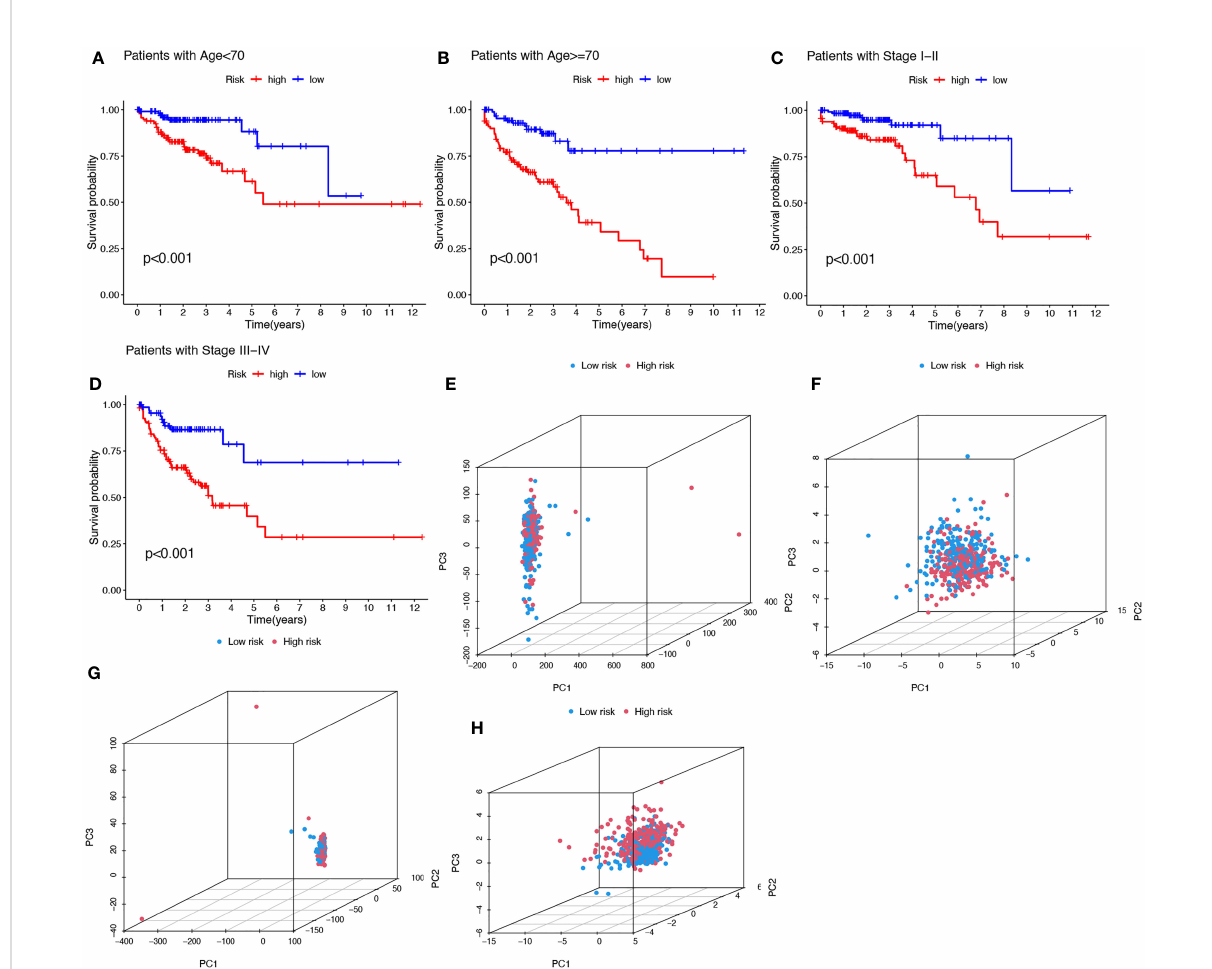
FIGURE 5 Kaplan-Meier plots depicting subgroup survival analysis strati fi ed by age (A, B) and stage (C, D) . PCA plots depicted the distribution of samples based on the expression of all genes (E) , cuproptosis-related genes (F) , lncRNAs (G) , and the ten lncRNAs of the prognostic signature (H)